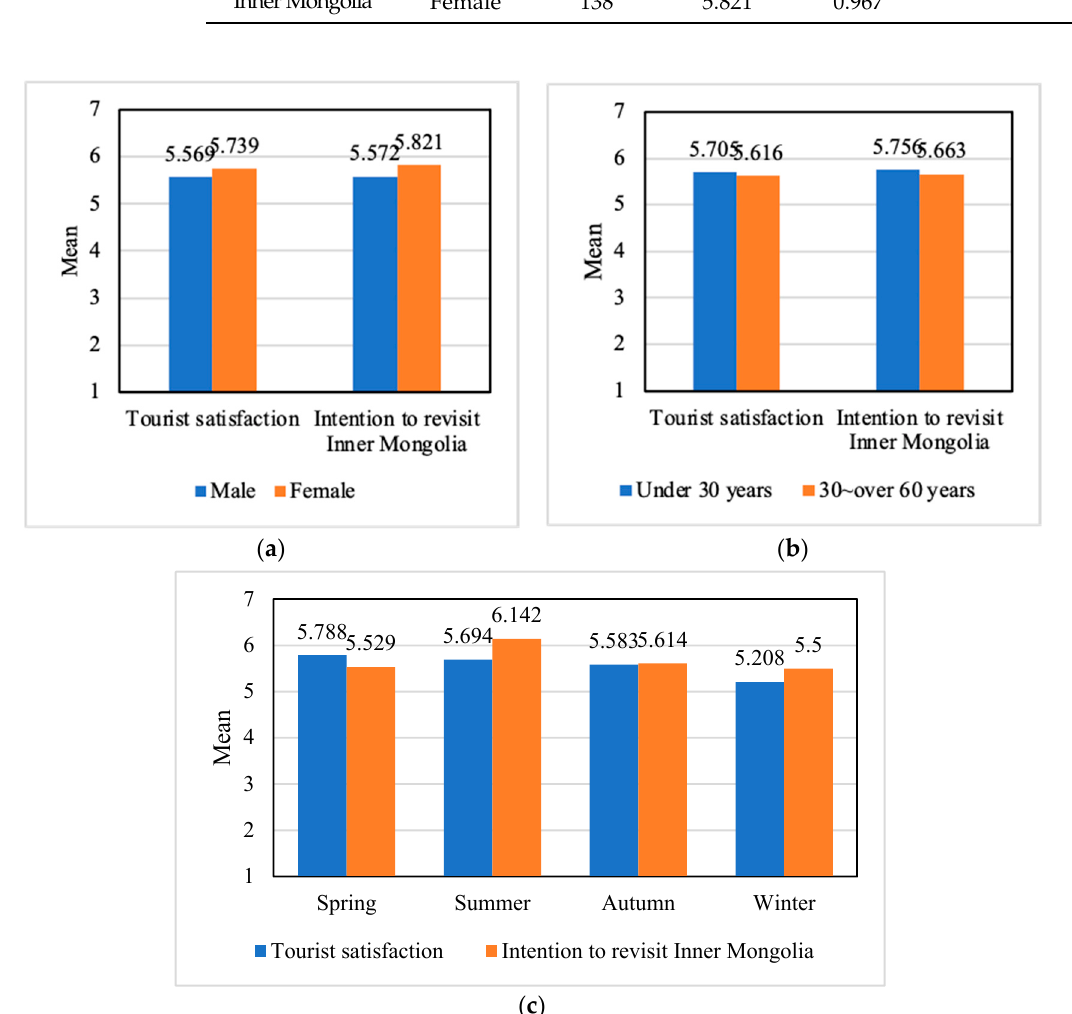
Figure 3. Result of means comparison of model outcomes by demographics of domestic tourists. ( a ) Means comparison of gender; ( b ) means comparison of age; ( c ) means comparison of season. Table 7. Results of ANOVA: season differences in tourist satisfaction and Intention to revisit Inner Mongolia.